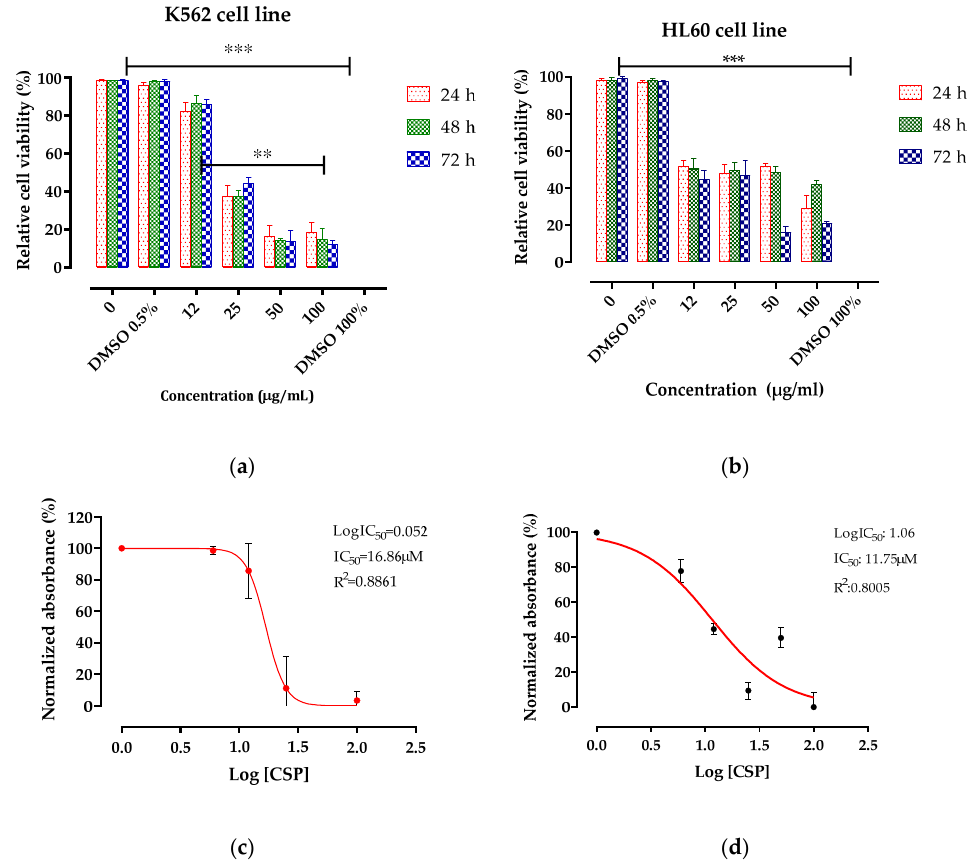
Figure 2. Cytotoxicity of the CSP extract for K562 and HL60 cells. ( a ) K562 and ( b ) HL60 cell viability after 24–72 h of treatment with different concentrations of the extract (12–100 µg/mL). The IC 50 for K562 ( c ) and HL-60 ( d ) was estimated using nonlinear regression (GraphPad Prism v. 5 software). The absorbance values were measured at the wavelength of 570 nm and the mean values ± SD of three experiments are displayed along with a representative IC 50 curve. The cell viability was estimated by the MTT assay. ** p < 0.01;*** p < 0.001.